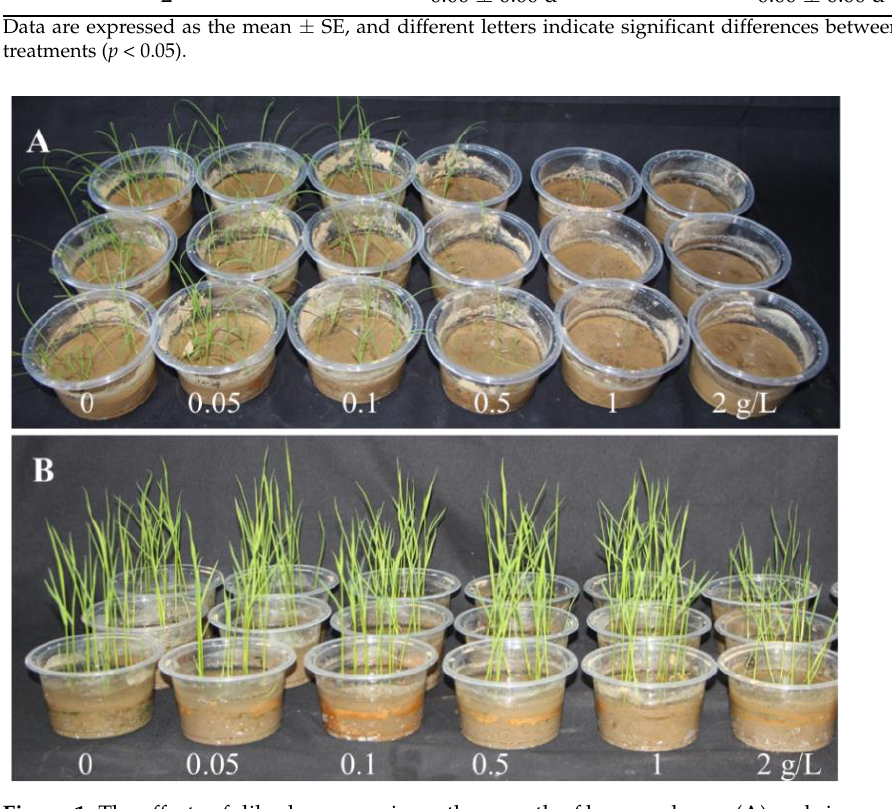
Figure 1. The effects of dihydrocoumarin on the growth of barnyardgrass ( A ) and rice seedling ( B